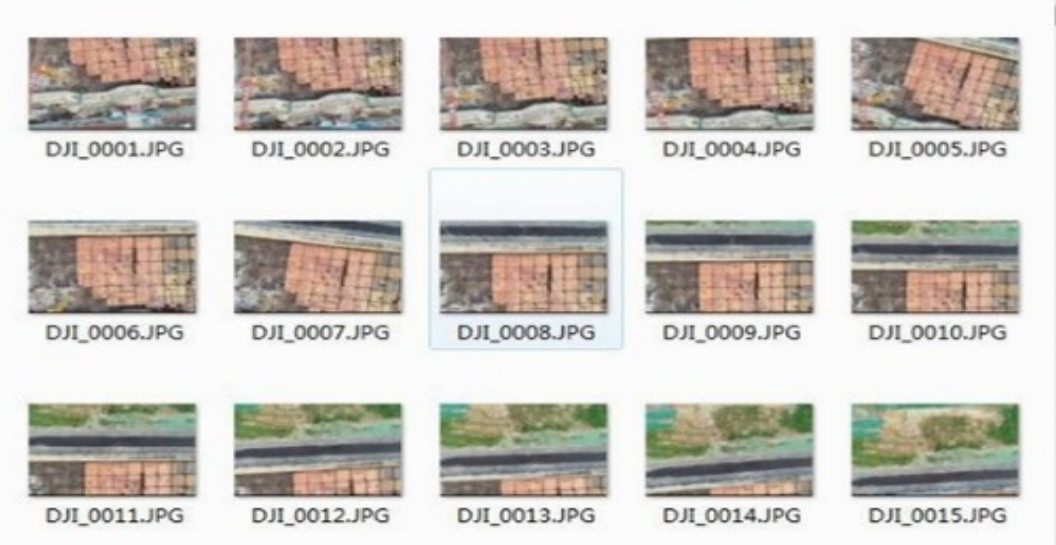
Figure 5. The image of the construction site collected by UAV.